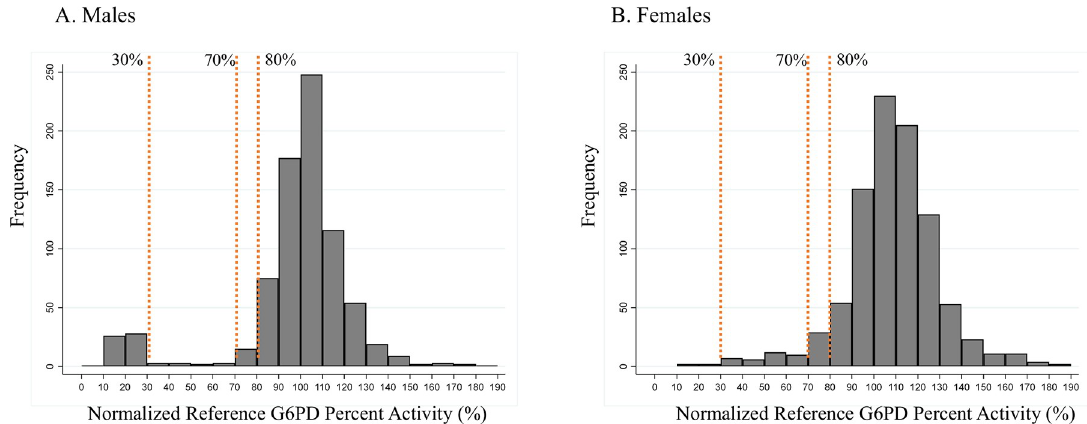
Fig 1. Histogram showing the distribution of G6PD activities in the study population. The frequency is plotted against the normalized reference assay G6PD activity in 10% increments for A) males, and B) females. The 30%, 70%, and 80% activity limits are indicated on each plot. G6PD, glucose-6-phosphate